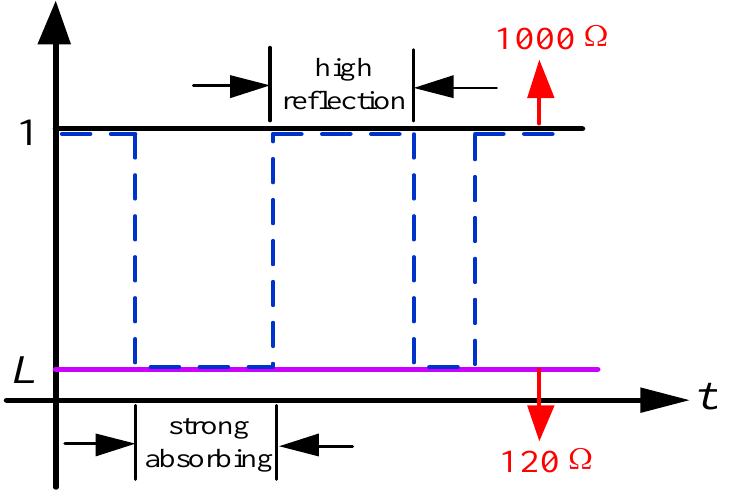
Figure 2. The modulation mechanism of AFSS structure.